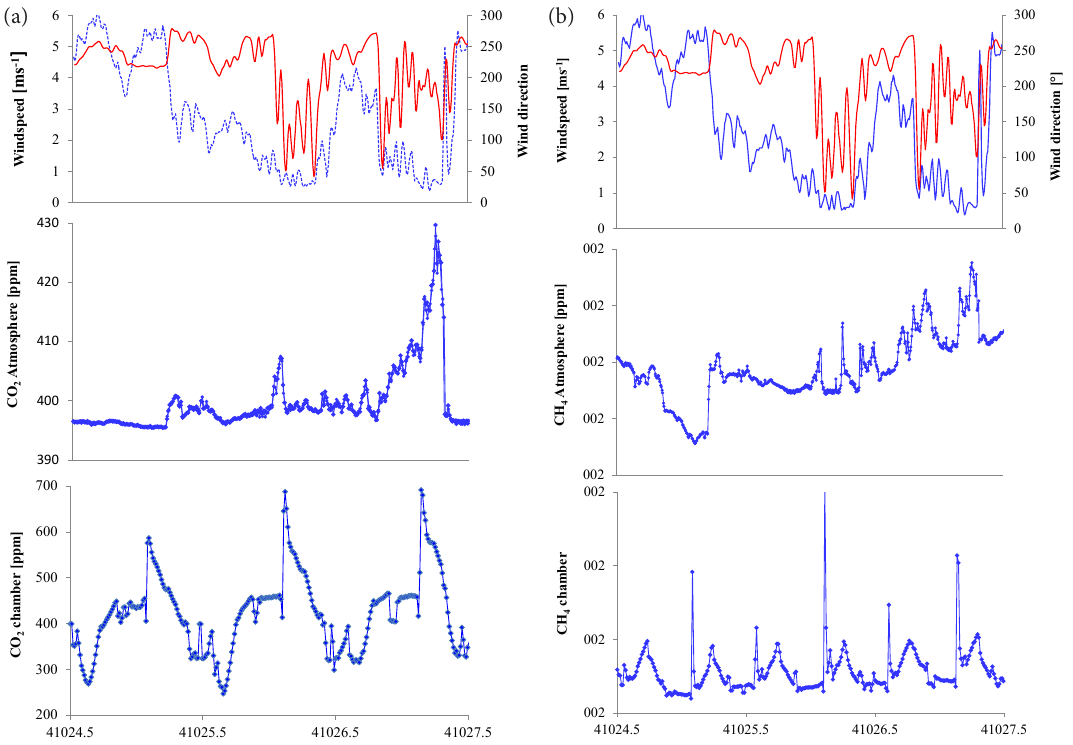
Figure 5. (a) Time series of CO 2 mixing ratios at the chamber outlet and in the atmosphere along with meteorological conditions (20min moving average). In the upper panel, the dashed blue line indicates the wind speed. (b) The same but for CH 4